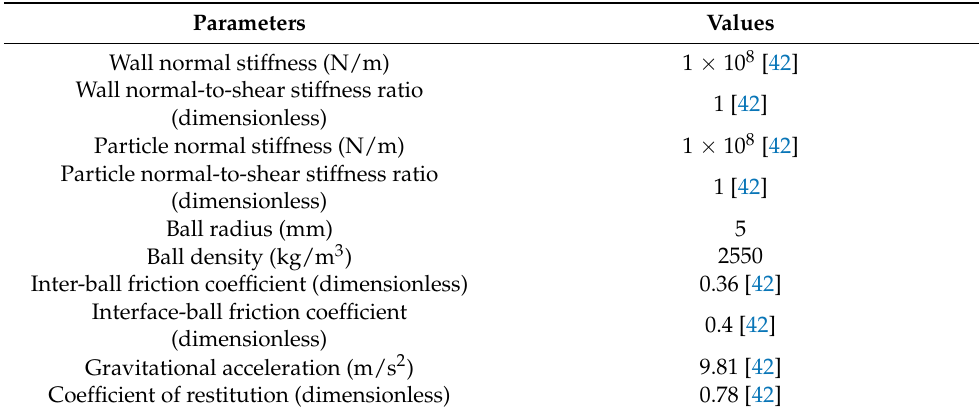
Table 1. DEM input Table 1. DEM input parameters.